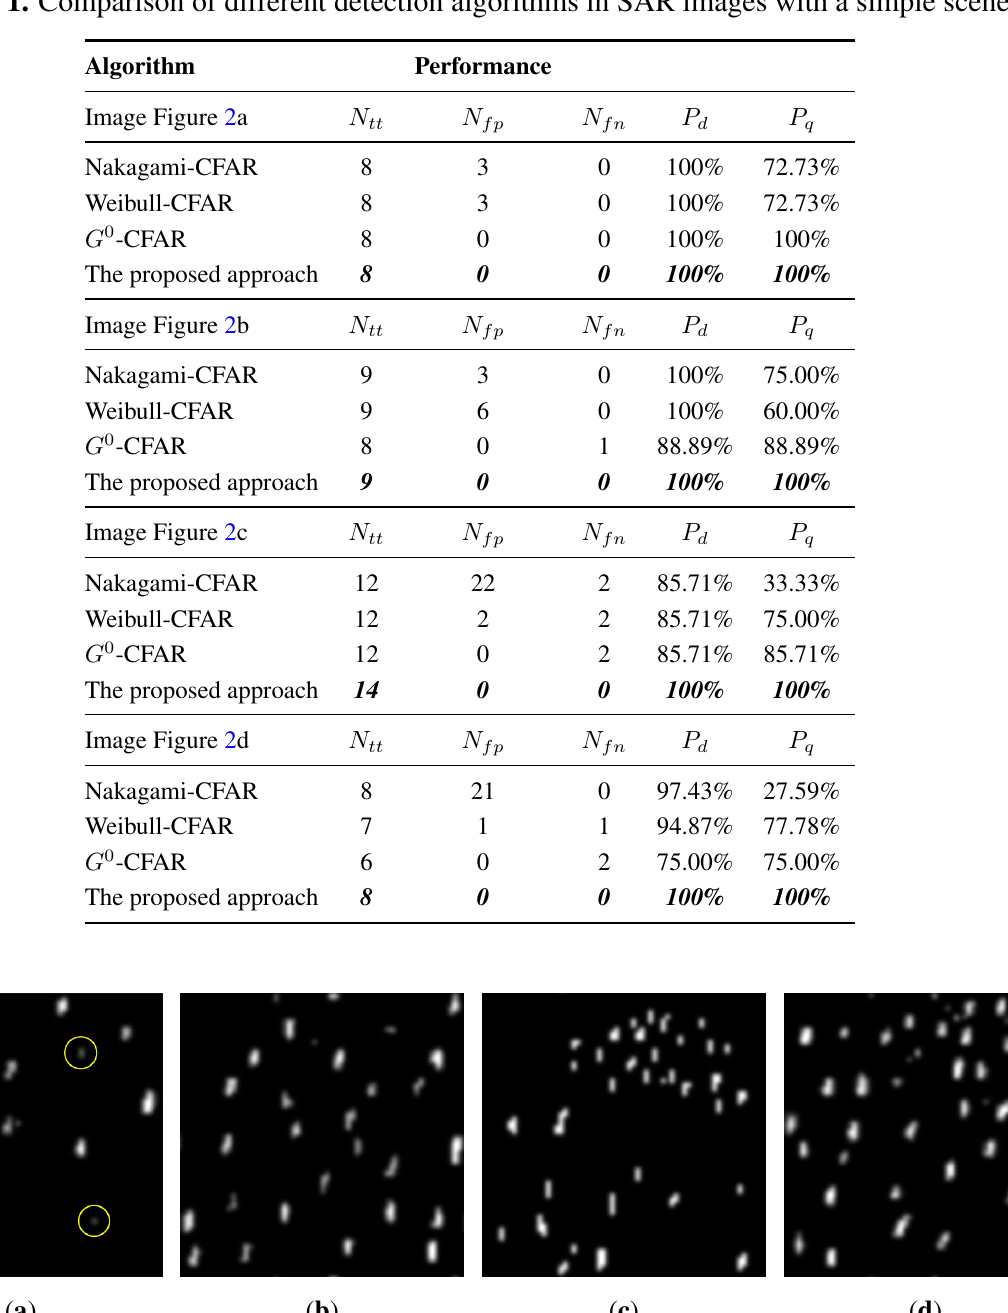
Table 1. Comparison of different detection algorithms in SAR images with a simple scene.